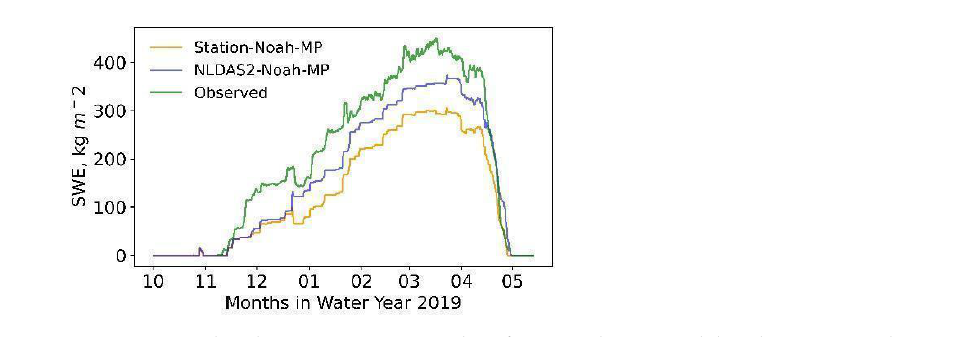
Figure 7. Simulated Snow Water Equivalent from Noah-MP Model and Station-Noah-MP versus the Observed values from WY2019.